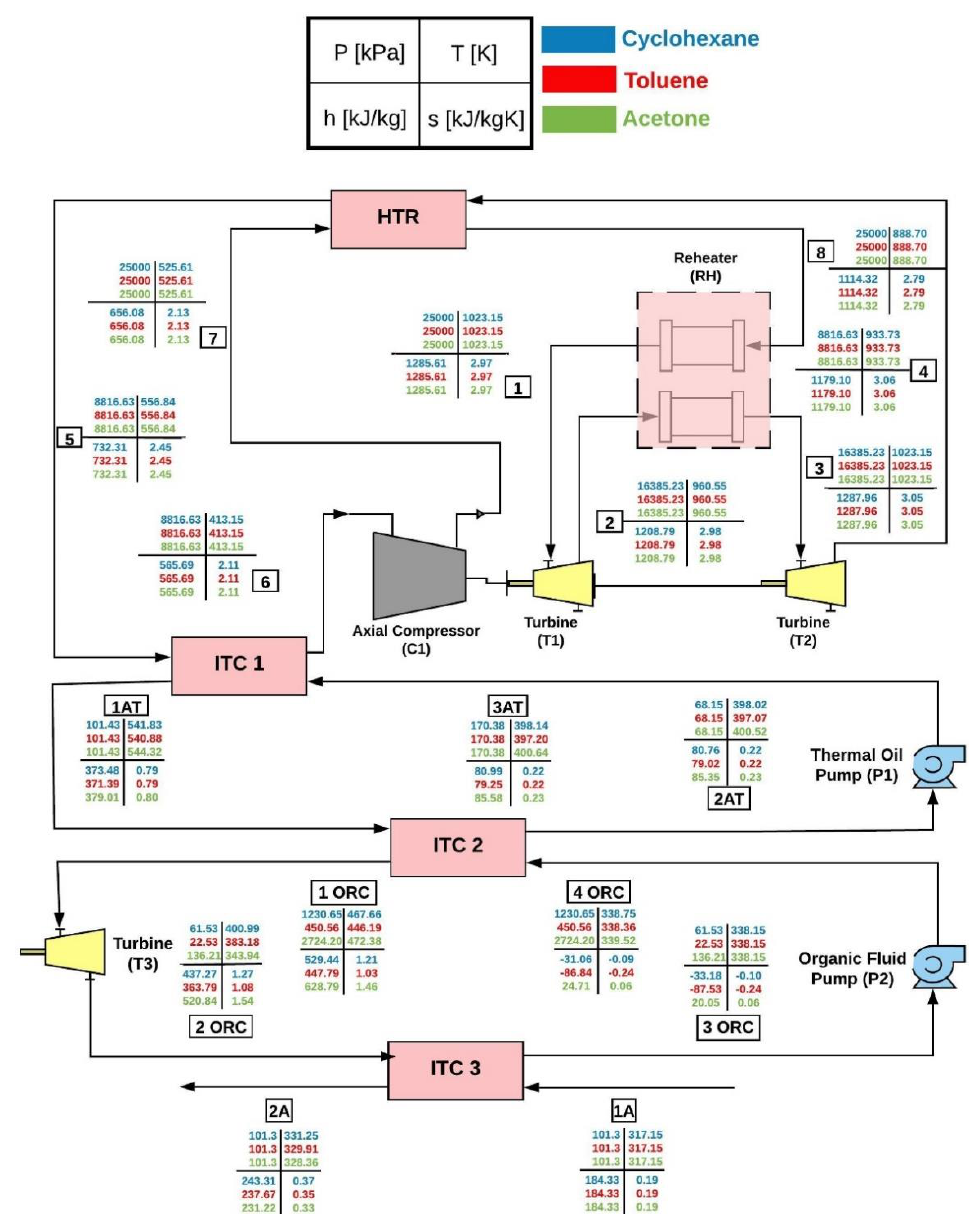
Figure 1. Physical structure of the Brayton S-CO 2 integrated into an organic Rankine cycle (ORC) as a bottoming cycle.